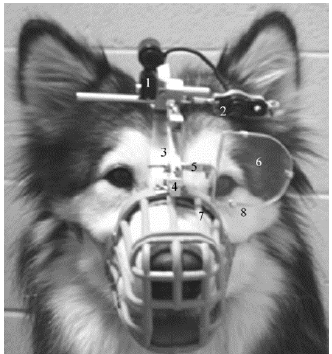
Figure 10. Using a head-mounted, eye-tracking system with dogs [110].